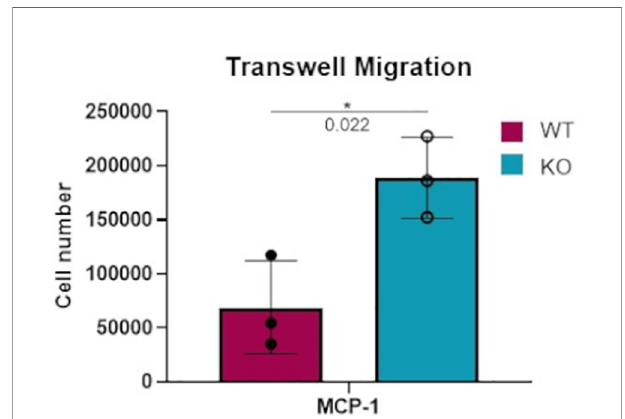
FIGURE 4 | Increased transwell migration toward MCP-1 in Dgka -/- BMDMs. 3x10 5 WT and Dgka -/- BMDMs were FBS-starved for 24h, then plated into